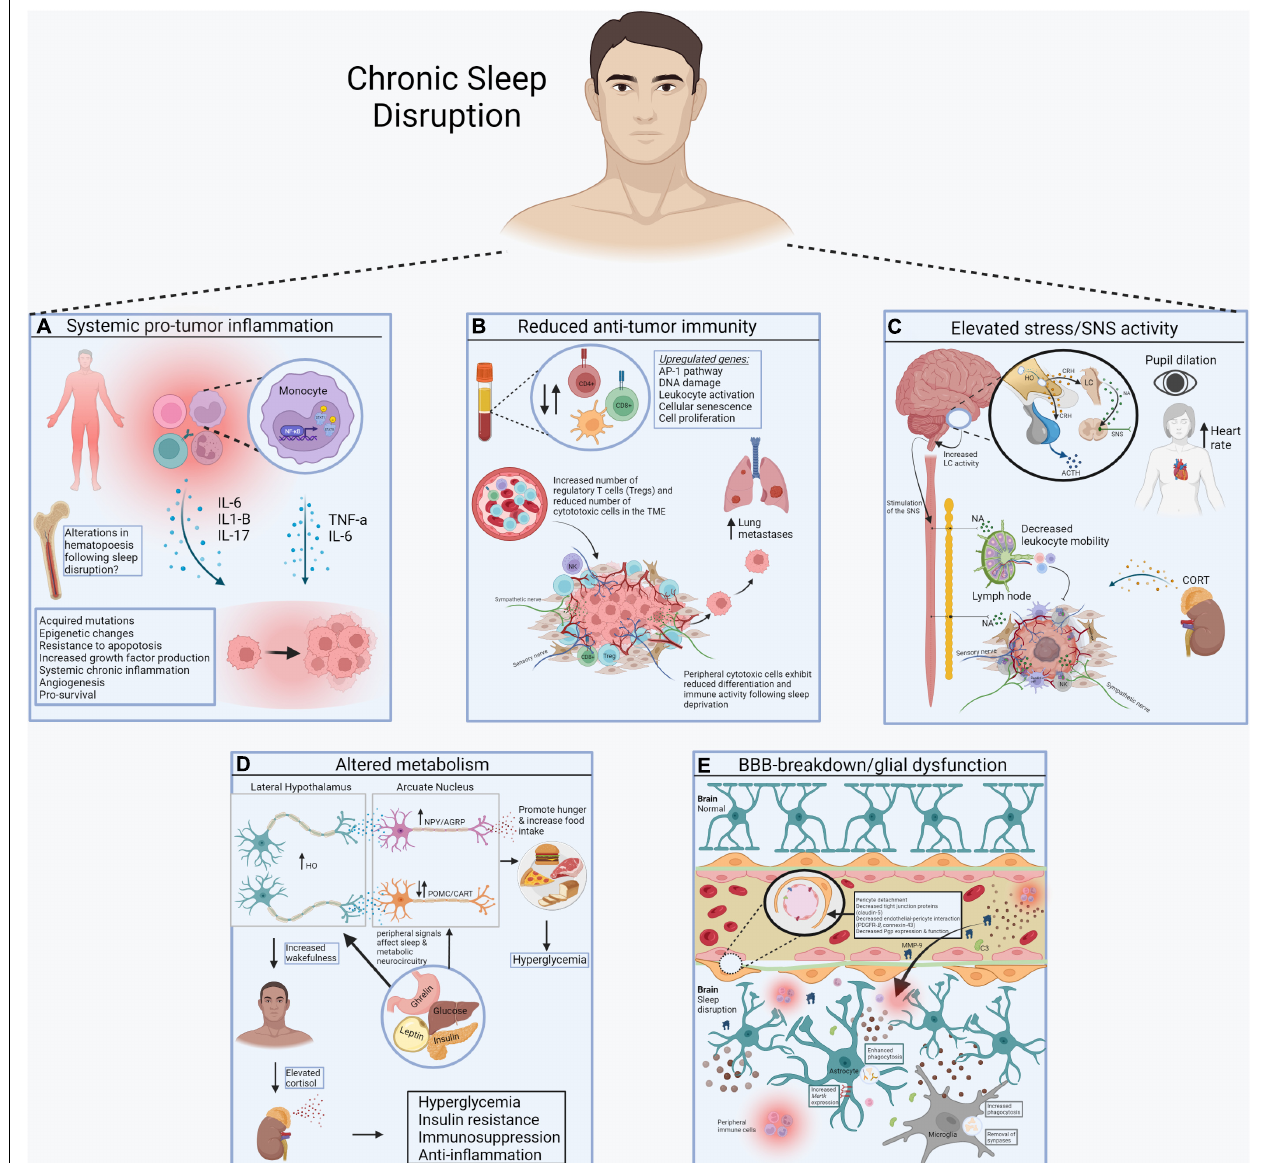
FIGURE 1 | Systemic consequences of sleep disruption. (A) Sleep disruption-induced inflammation establishes a pro-tumor inflammatory environment in peripheral tissues, including the increase in proinflammatory cytokines like IL-6, IL1-b, and IL-17, mediated by the transcription factor NF-kB. (B) Sleep disruption reduces anti-tumor immunity. Alterations in the number of circulating and intra-tumor lymphocytes and myeloid cells contributes to immunosuppression in cancer. Reduced differentiation of cytotoxic cells further prevents cancer elimination. (C) Sleep disruption engages the HPA axis and autonomic nervous system. Glucocorticoids and catecholamines have widespread effects on the immune system and energy balance important for tumor progression. (D) Sleep disruption alters systemic metabolism. Wake-promoting neurons (e.g., hypocretin/orexin) regulate the activity of others that control food intake and metabolic health (e.g., POMC, AgRP, NPY neurons). (E) Sleep disruption promotes the breakdown of the blood brain barrier (BBB). Disrupted sleep results in vascular endothelial cell dysfunction and inflammation, further contributing to BBB impairment. This allows inflammatory molecules in blood to reach the brain, where they alter the function of sleep/wake regulatory systems (Made with